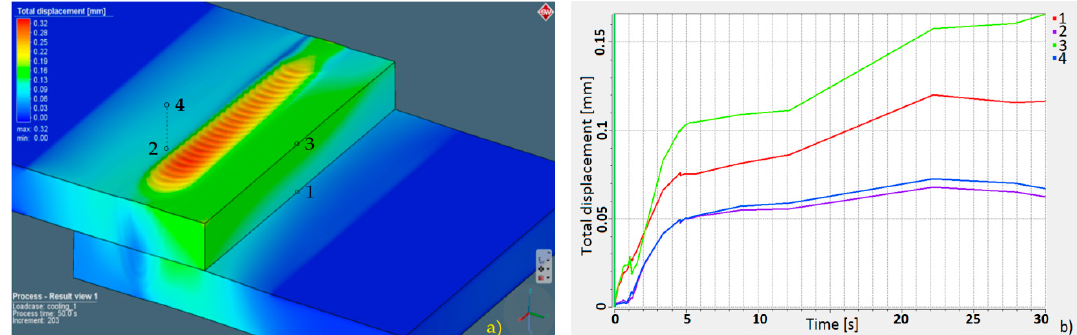
Figure 9. Total displacement: ( a ) distribution map and ( b ) displacement chart according to measurement points.